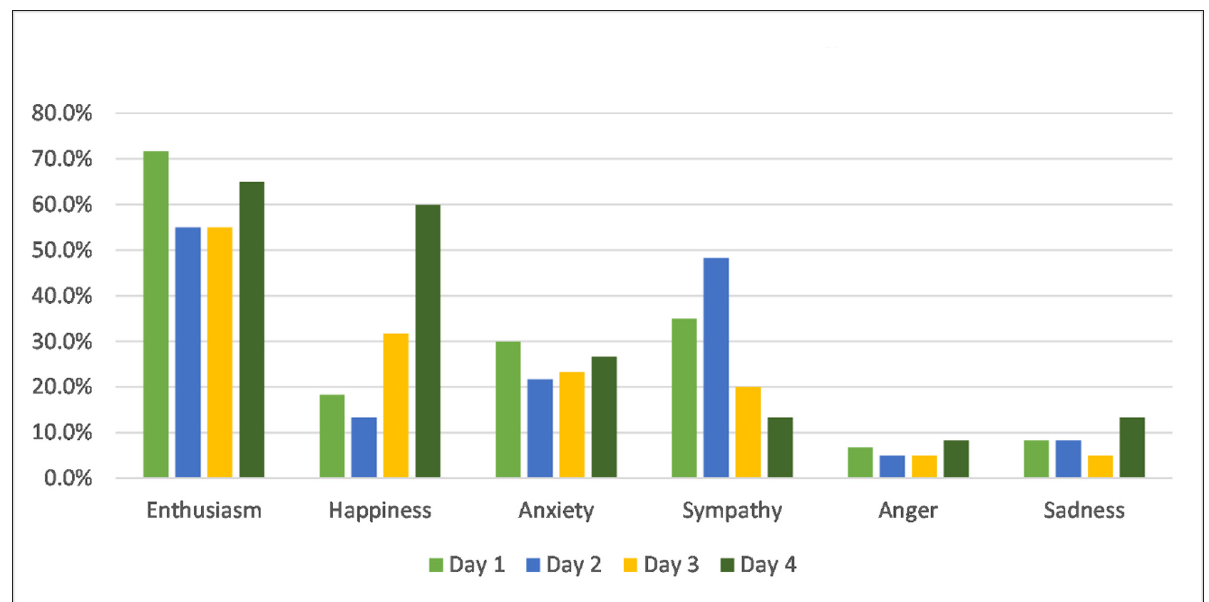
Figure 2: Reported Emotions by Day 2018